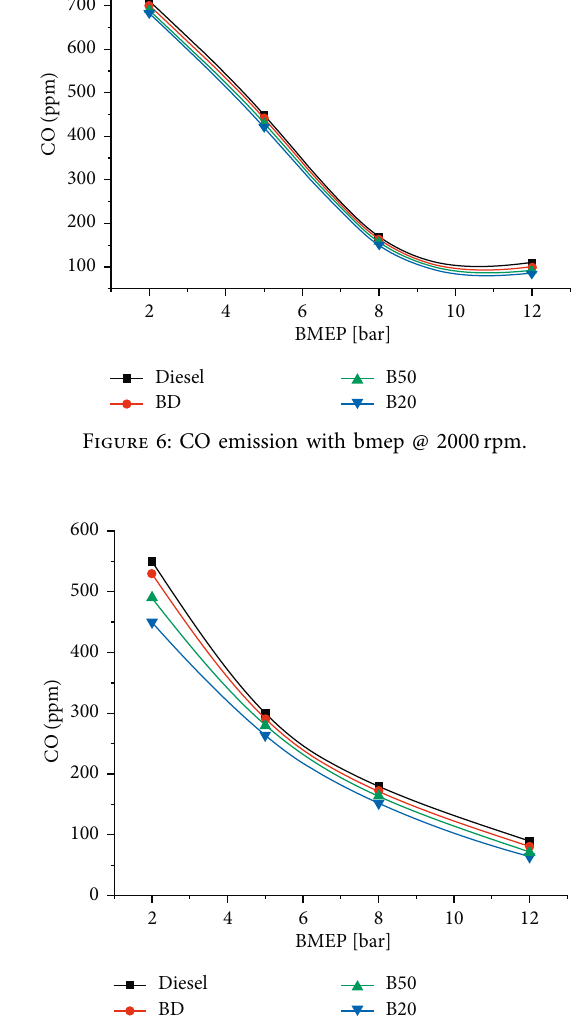
Figure 7: CO emission with bmep @ 3000rpm.